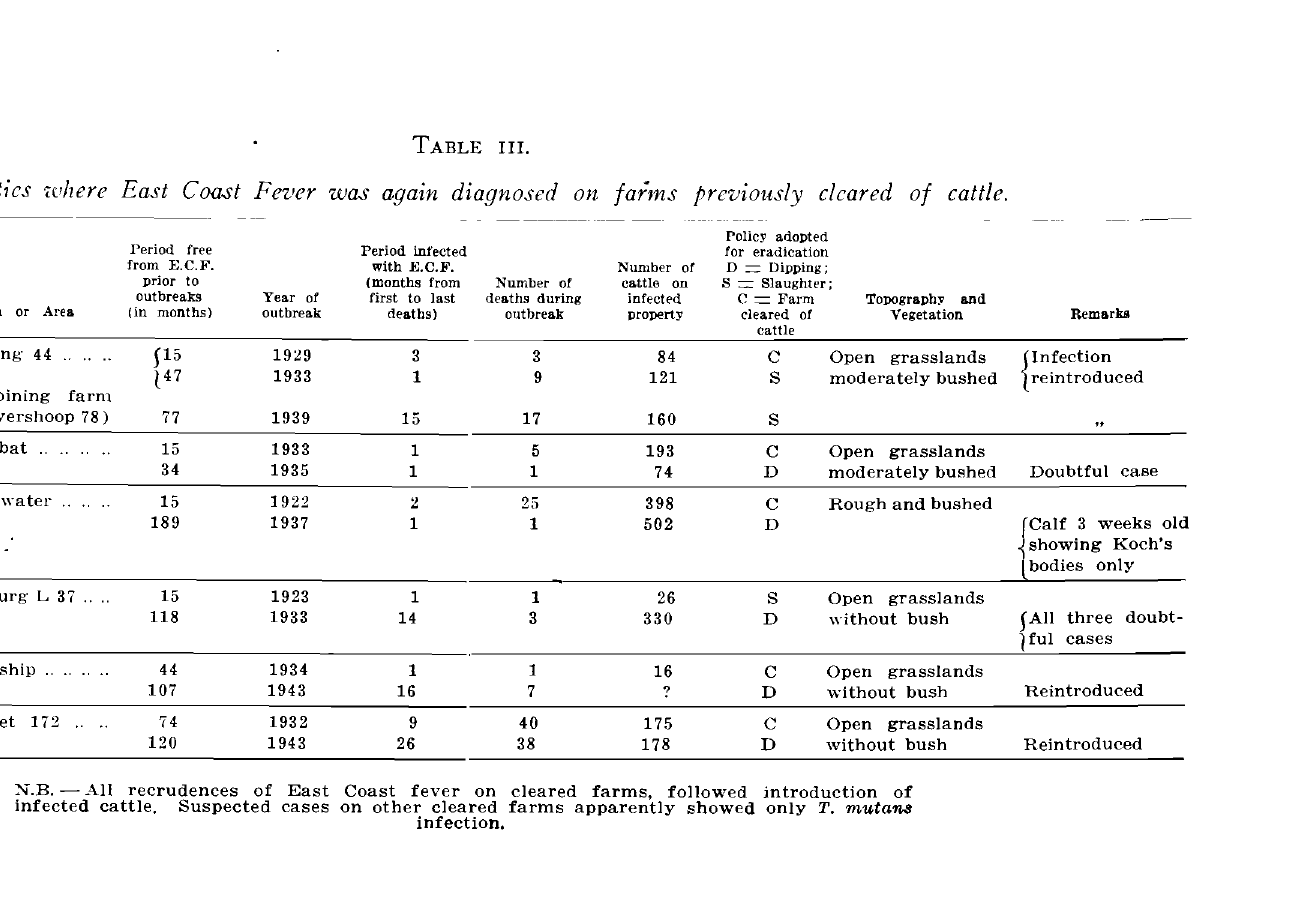
Policy adopted = Divping;